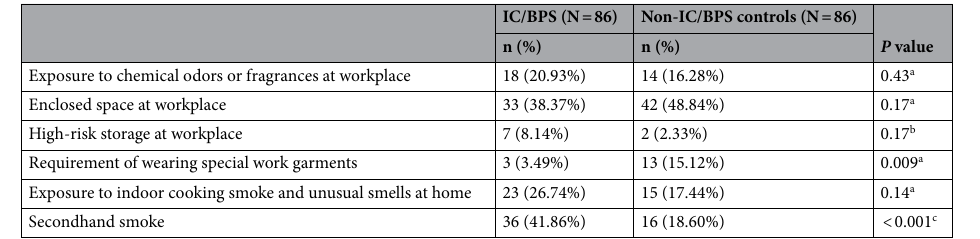
Table 2. Comparison of air quality and exposure to living and workplace environments. N number. a Chi- square test, b Fisher’s exact test, c t